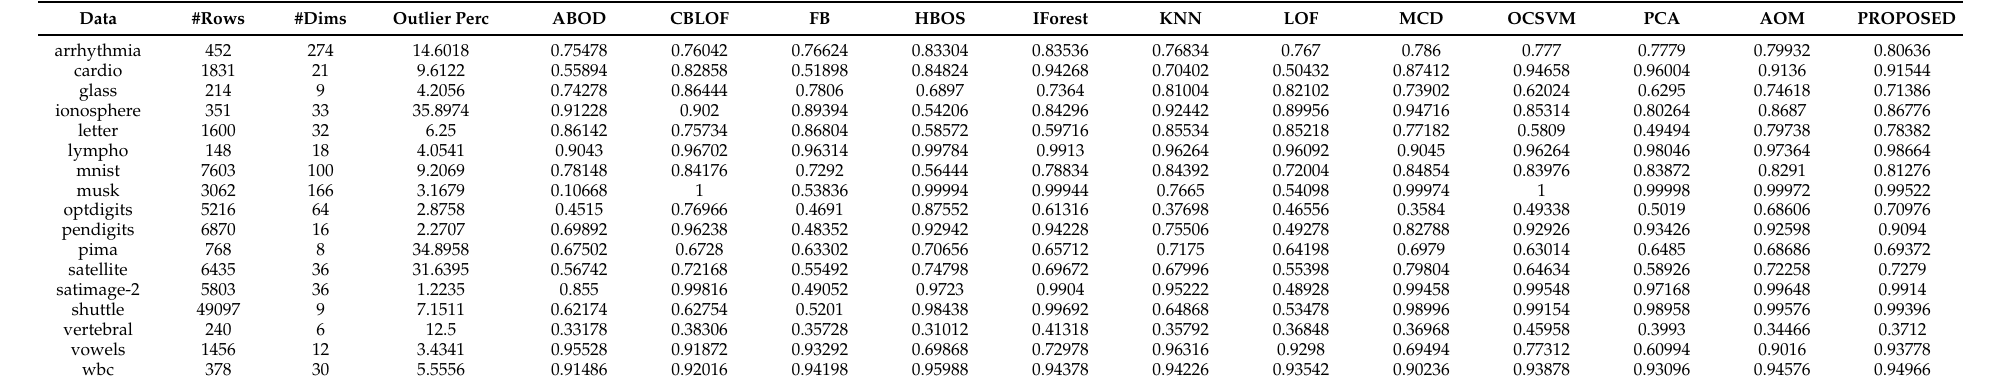
Table A1. Comparison of ROC results (average of 5 trials).